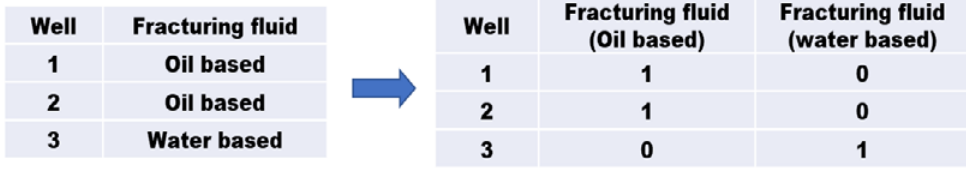
Figure 2. Application of one-hot encoding for categorical variables.